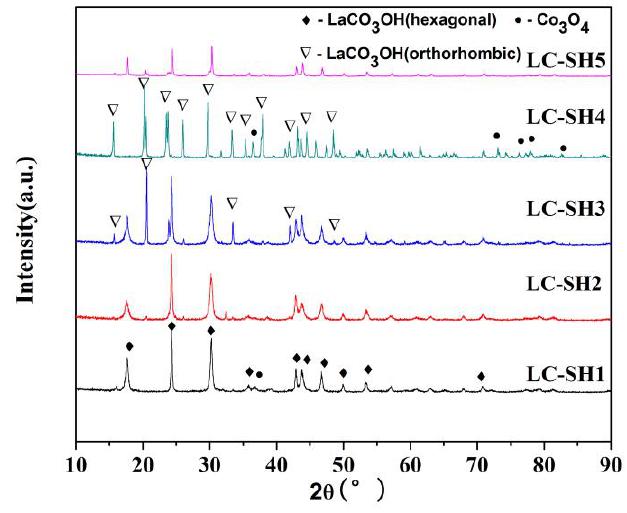
Figure 5. XRD pattern of catalysts with different amounts of nitrogen.